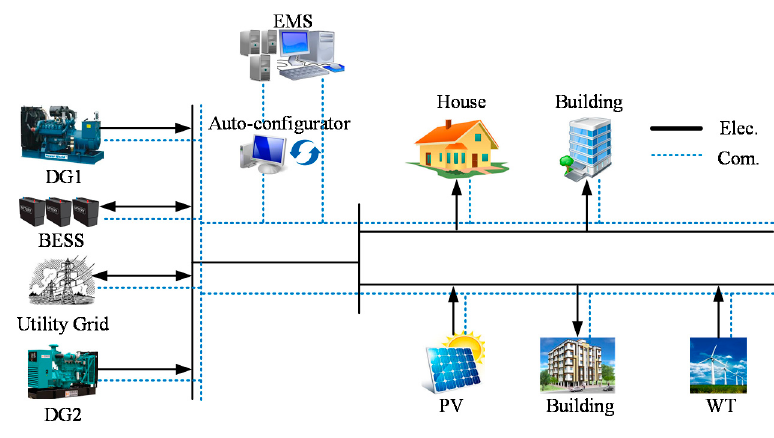
Figure 1. Microgrid system configuration.